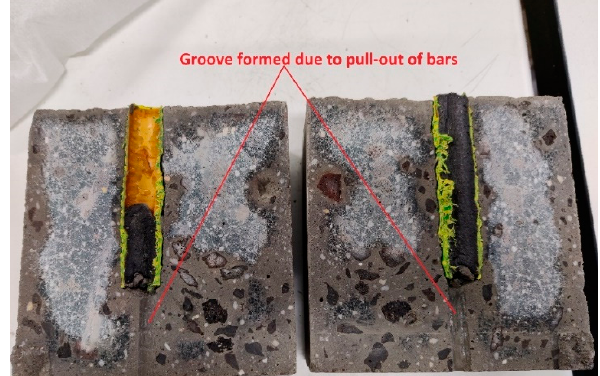
Figure 15. Cross-sectional view of cut Pull-out specimens.